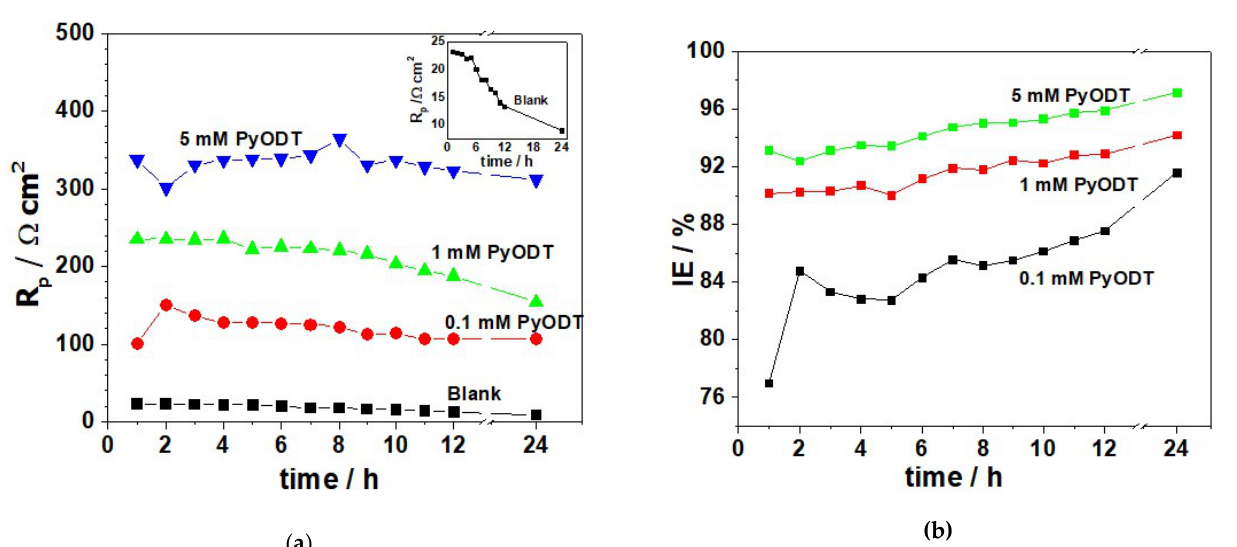
Figure 6. Variation of the polarization resistance ( a ) and inhibition efficiency ( b ) during the exposure of C-steel in 1.0 M HCl solution in the absence and the presence of selected concentrations of Py- ODT.